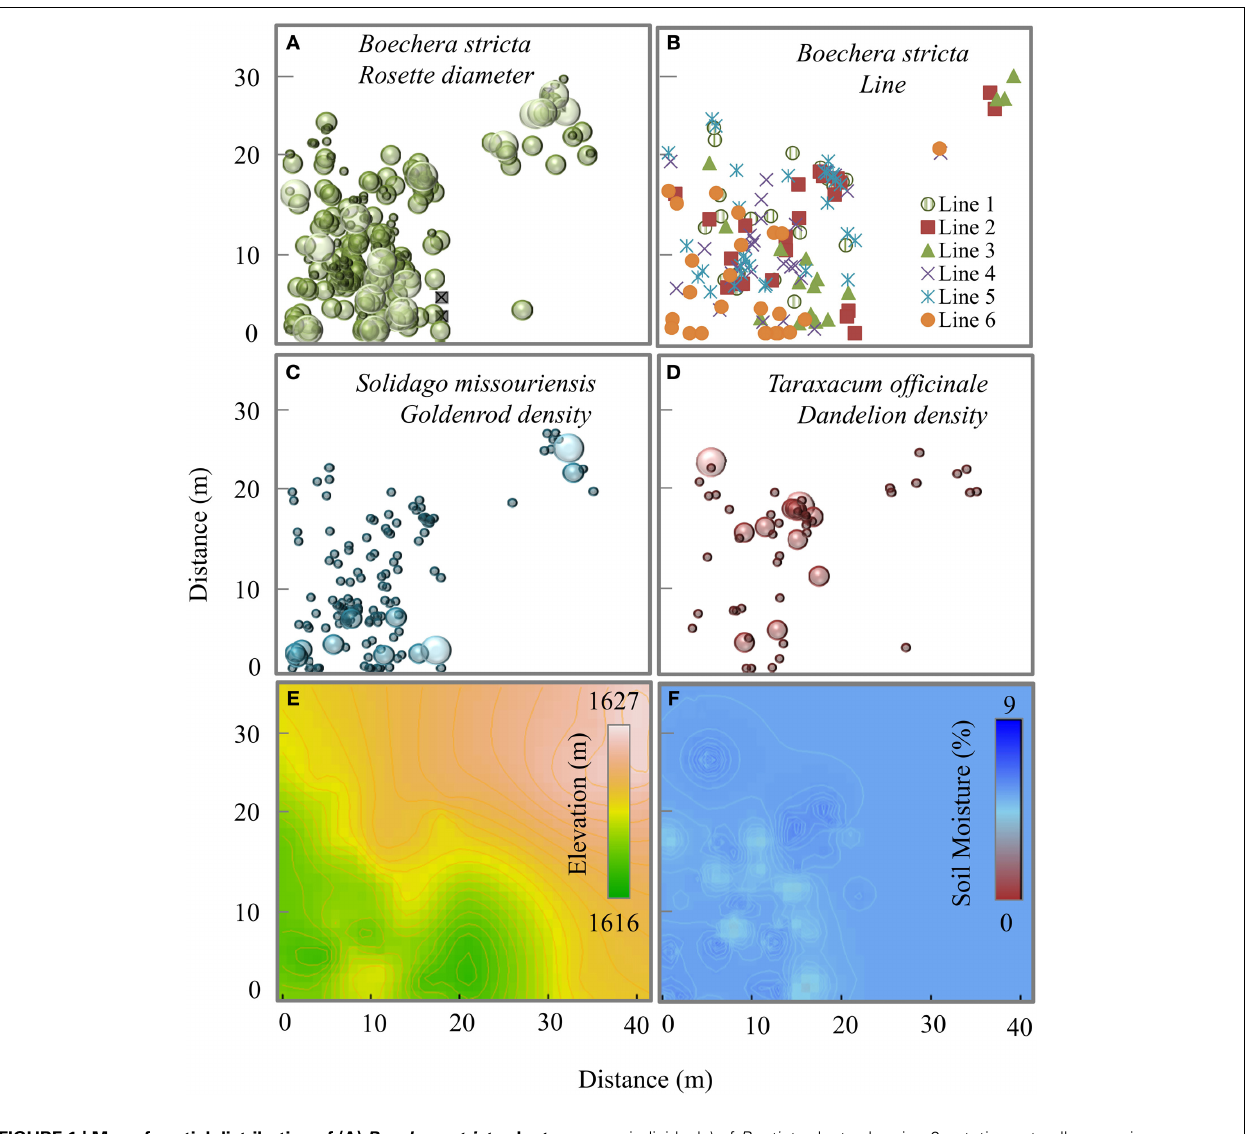
individuals) of B. sticta plants showing 6 putative naturally occurring near-inbred lines ( line 1–6) (C,D) number of Solidago and Taraxacum plants within a 15cm radius around each B. stricta plant, diameter of the circles correspond to the number classes 1–20, 21–40, and 41–60. (E,F) Kriged maps of elevation and soil moisture for the study